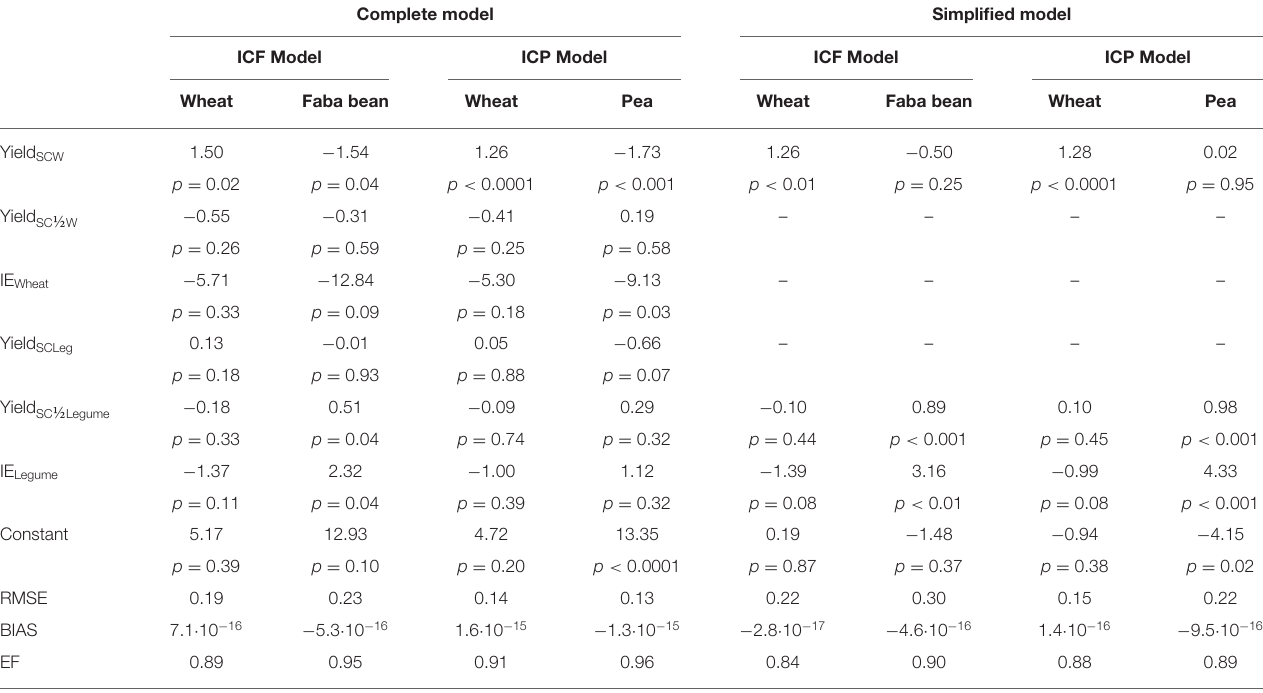
TABLE 2 | Parameters values and adjustment quality for the complete and simplified